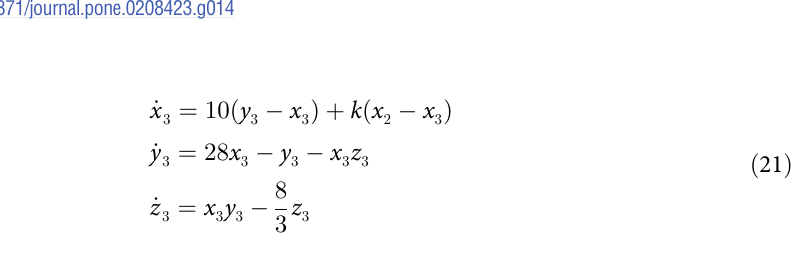
where k (k = 0,1,3,5) is the coupling strength regulates the interaction from X X 2 ! X 3 . All time series become completely synchronized when the coupling strengths k � 8.